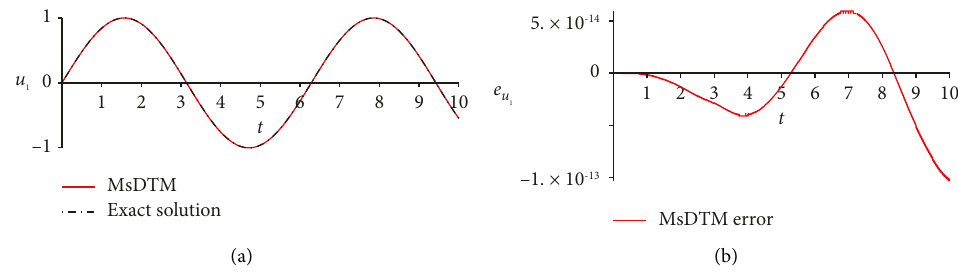
Figure 1: The approximate solution component u